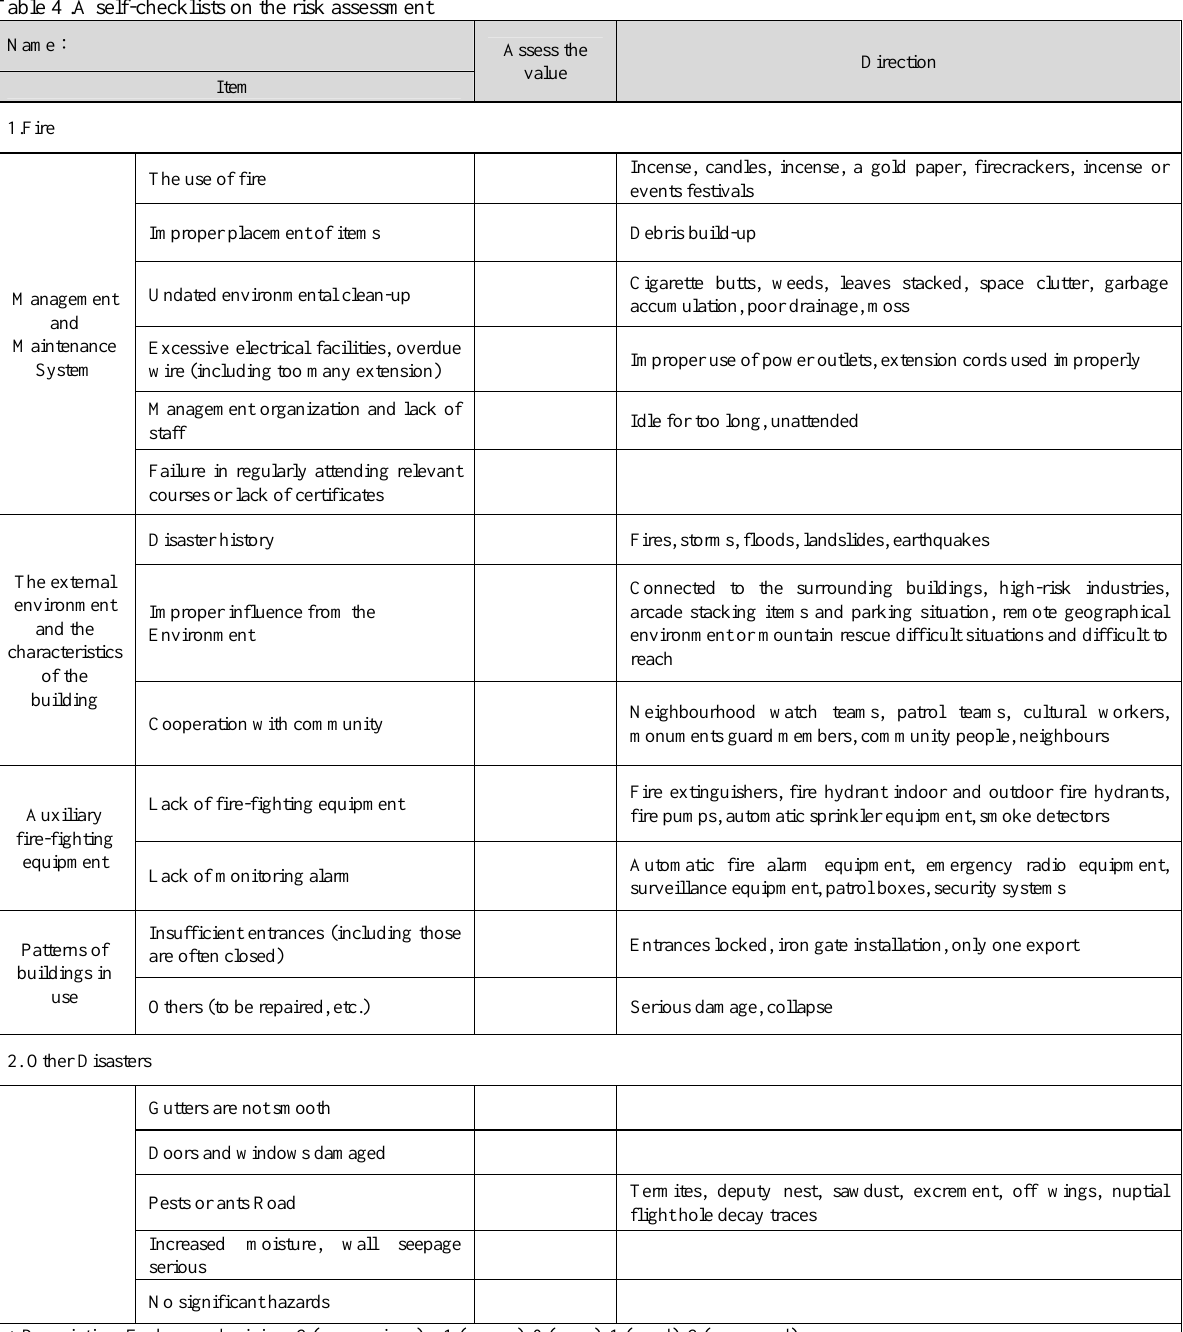
Table 4 .A self-checklists on the risk assessment Name ： Assess the